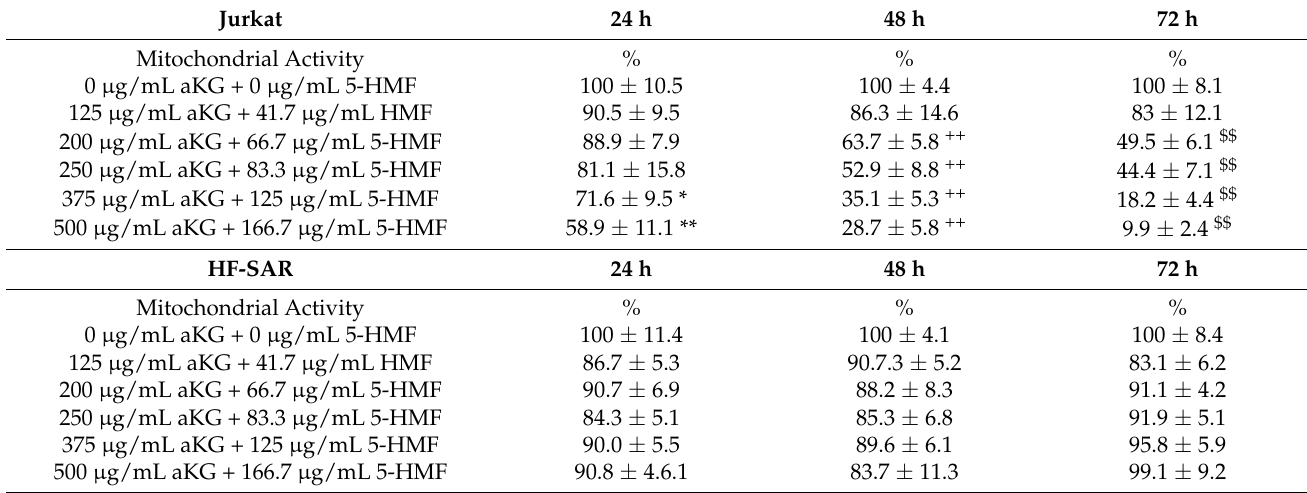
Table 2. Mitochondrial activity (%) of the Jurkat cell line (A) and of the HF-SAR (B) after incubation for 24, 48, and 72 h in the absence or presence of different combinations of aKG + 5-HMF solutions ( n = 5). * p < 0.01: significance between 24 h of incubation without aKG + 5-HMF and with the combined solutions of aKG + 5-HMF. ** p < 0.001: significance between 24 h of incubation without aKG + 5-HMF and with the combined solutions of aKG + 5-HMF. ++ p < 0.001: significance between 48 h of incubation without aKG + 5-HMF and with the combined solutions of aKG + 5-HMF. $$ p < 0.001: significance between 48 h of incubation without aKG + 5-HMF and with the combined solutions of aKG + 5-HMF. Jurkat 24